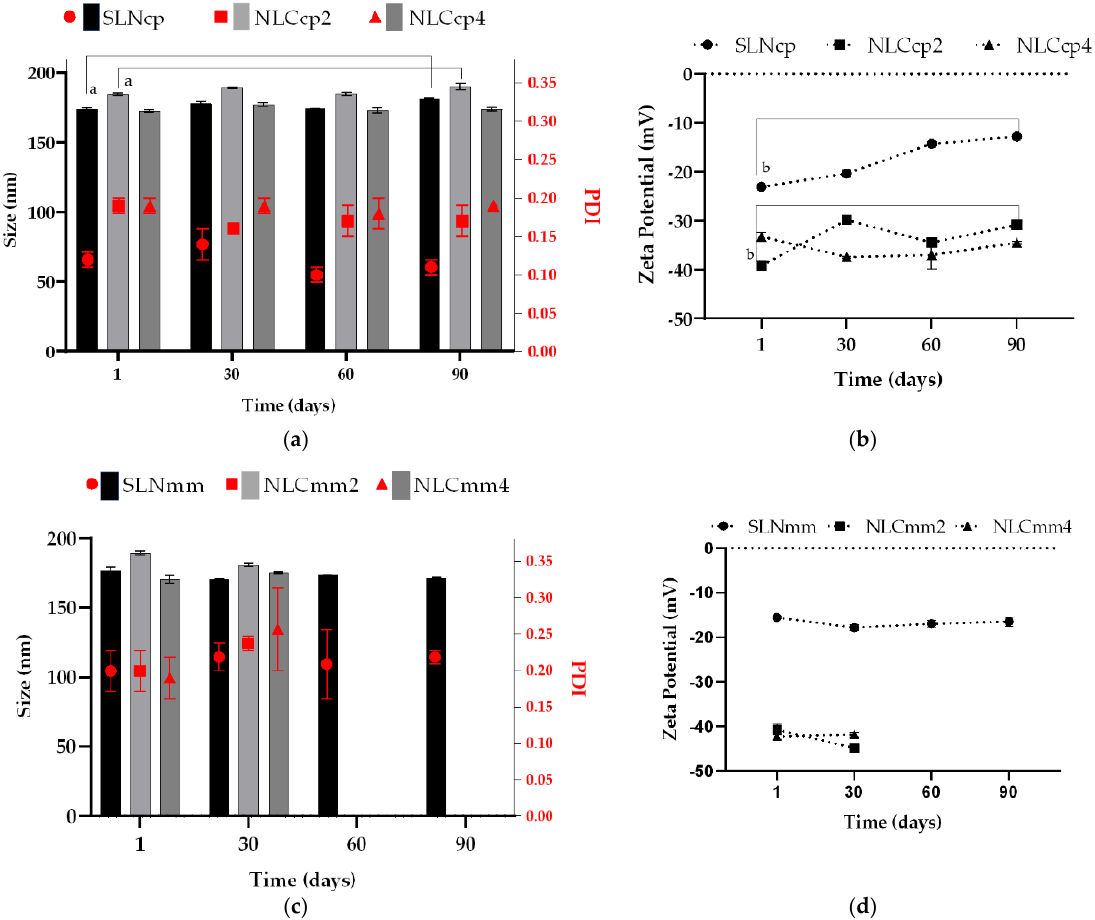
Figure 2. Particle size, polydispersity index, and zeta potential of CP ( a , b ) and MM ( c , d ) nanoparticles in different storage times. Statistics: Mean ± SD, n = 3. The results of each sample obtained throughout the storage were analyzed through ANOVA, with a Tukey-Kramer post-test. ‘ a ’ represents a statistical difference of day one vs. day ninety of the SLN and NLCcp2 for particle size; ‘ b ’ day one vs. day ninety of SLN and NLCcp2 for zeta potential. Significance was considered p < 0.05 for all tests. Observed a phase separation of NLCmm2 and NLCmm4 at day 60 and 90 (size, PDI, and zeta potential data are presented in Supplementary Materials, Table S1).